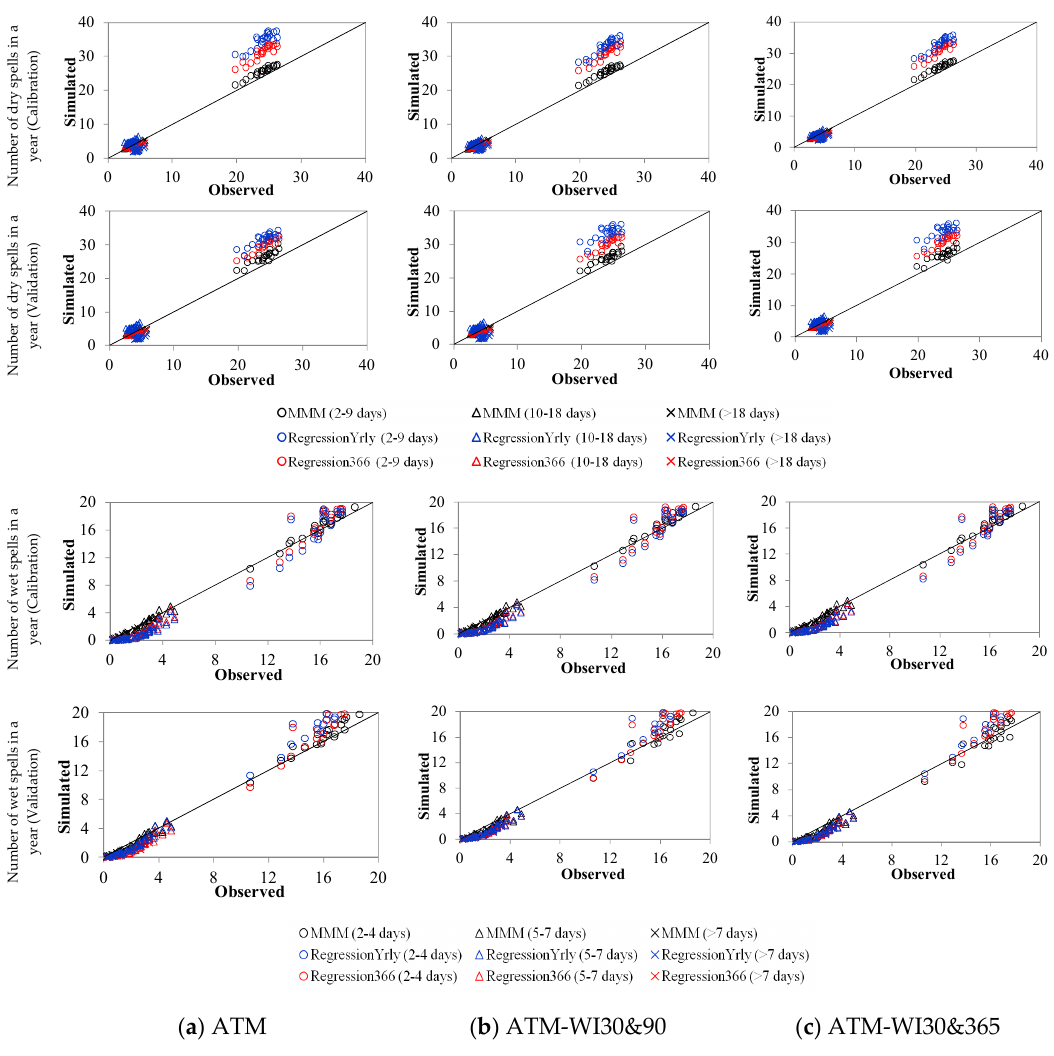
Figure 6. Number of dry and wet spells in a year at each of 22 rainfall stations for calibration and validation periods using the multisite downscaling model: ( a ) using ATM as predictors; ( b ) using ATM-WI30&90 as predictors; and ( c ) using ATM-WI30&365 as predictors. Dots on the plots represent stations. Black dots are for MMM, blue dots are for RegressionYrly and red dots are for Regression366 models.